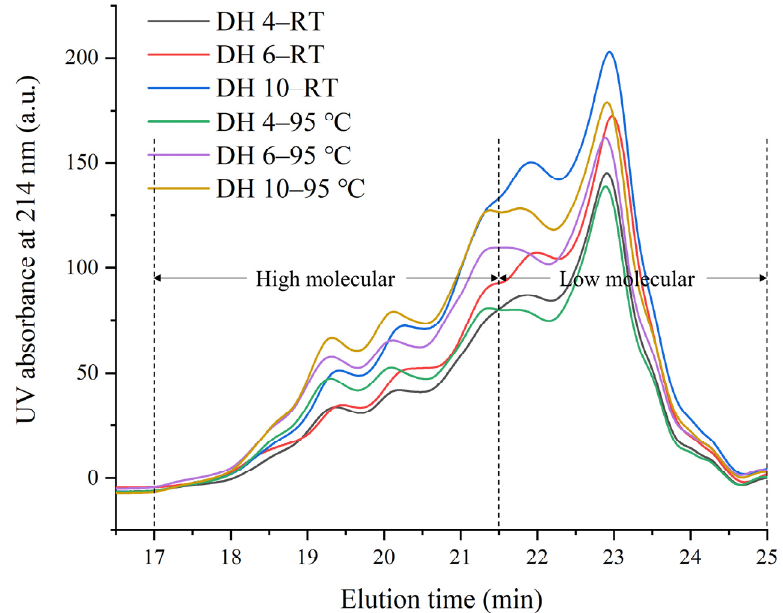
Figure 3. SE-HPLC profiles of heated and unheated gluten polypeptides. DH 4, DH 6, and DH 10 represent the degree of hydrolysis 4.0%, the degree of hydrolysis 6.0%, and the degree of hydrolysis 10.0%, respectively.